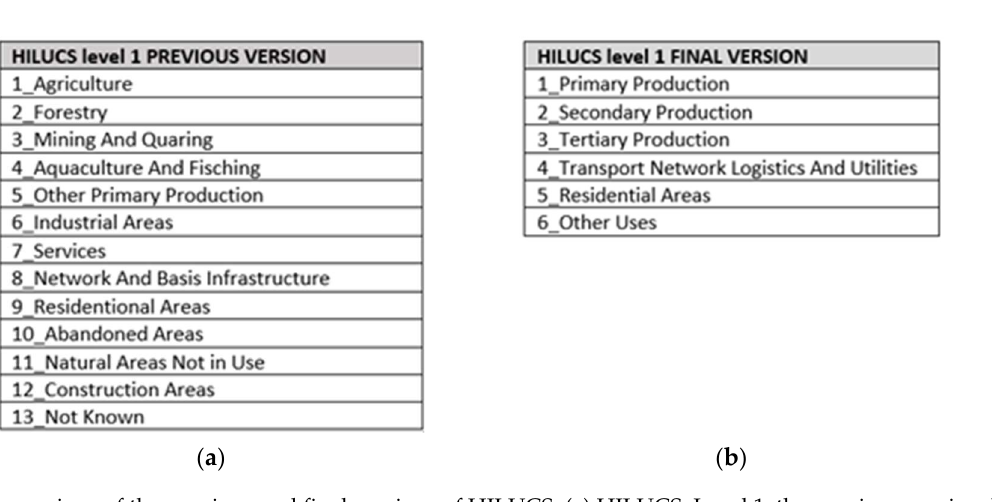
Figure 13. Comparison of the previous and final versions of HILUCS: ( a ) HILUCS, Level 1, the previous version, because it contained more class attributes, it seemed more understandable, and it contained construction areas, Natural Areas Not in Use and Not Known. ( b ) HILUCS, Level 1, the final version, is very simplified and therefore may not seem to be understandable. However, the presentation of datasets from all countries on the European website require it.